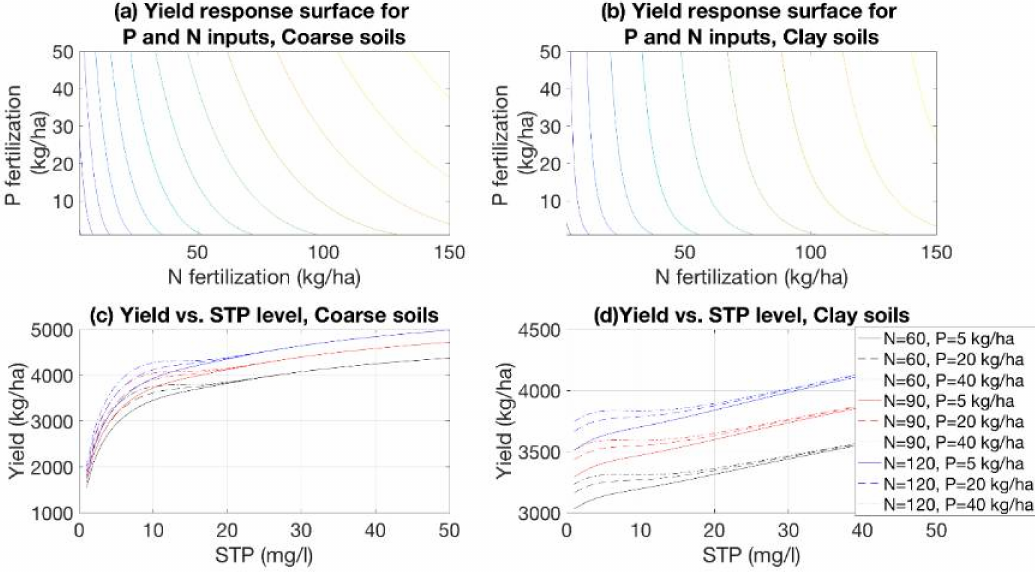
Figure 3. Above the simulated yield N-P-response surfaces for the fair STP class for ( a ) coarse and ( b ) clay soils. Below the yield as a function of STP for various P and N rates for ( c ) coarse and ( d ) clay